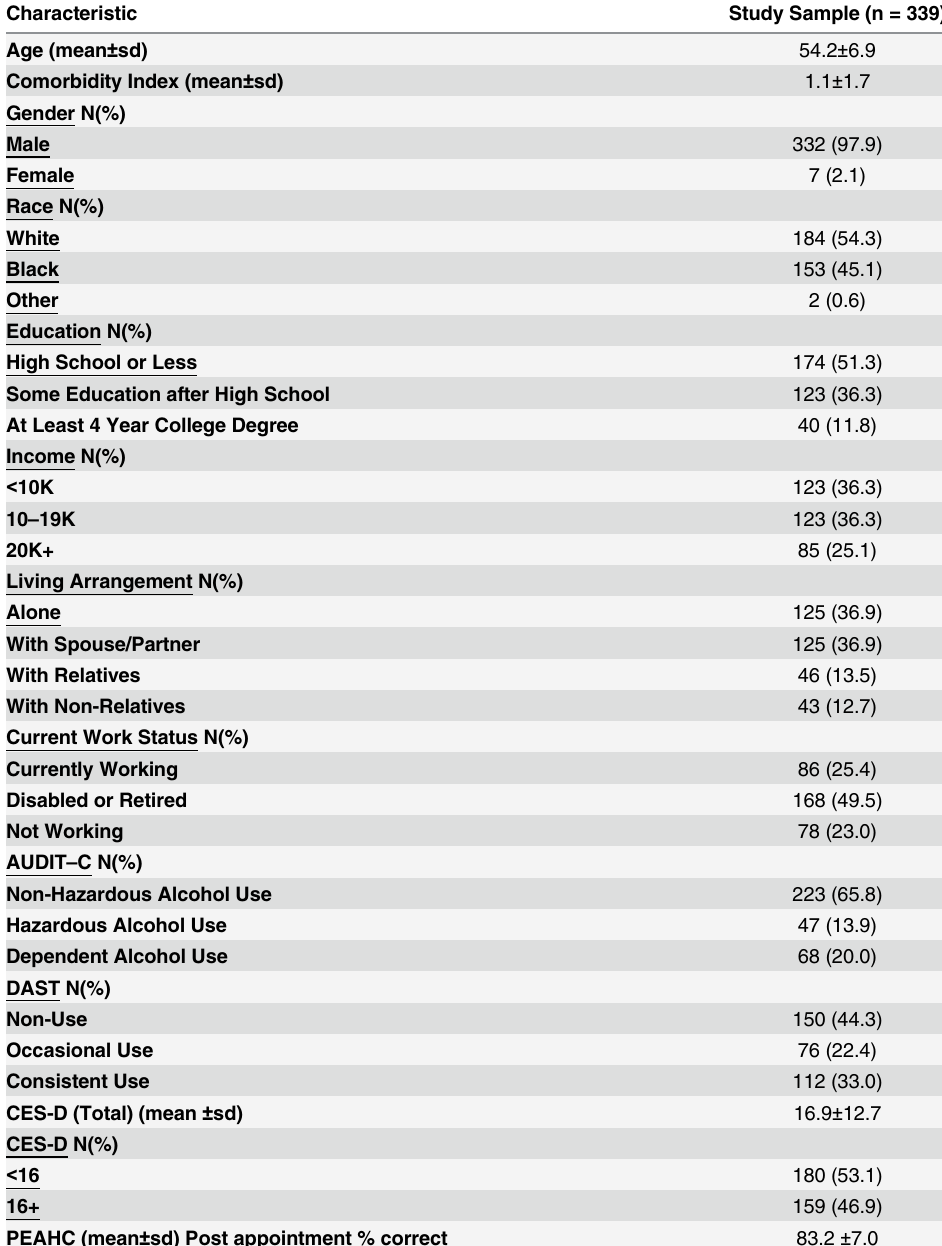
Table 1. Demographic and Clinical